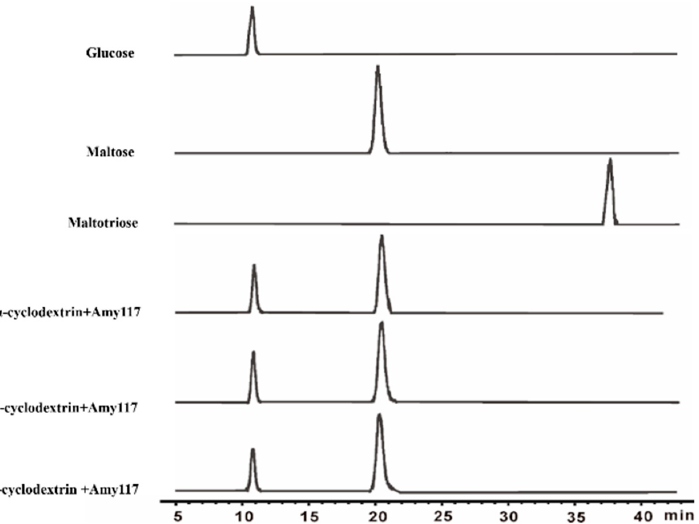
Figure 3. HPLC–ELSD chromatogram of hydrolysis products from α -cyclodextrin, β -cyclodextrin, and γ -cyclodextrin by Amy117. The separation was achieved using Agilent Zorbax Carbohydrate Analysis column (150 mm × 4.60 mm, 5 um). Mobile Phase: acetonitrile/water 75:25 (v/v), the flow rate was 1 mL/min. A drift tube temperature of 90 °C and a nebulizer gas flow rate of 2 L/min were used.